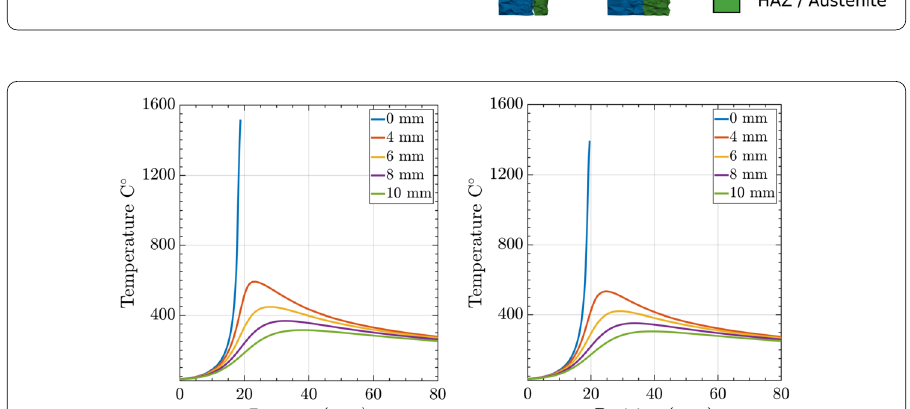
the plate using lines A and C. Moreover, these lines are shifted in the y -direction to obtain more information about temperatures reached in the remaining plate. As shown in Fig. 6, the maximum temperature is reached on the top of the plate. The curves closest to the cutting line vanish as the position corresponds to the liquid phase